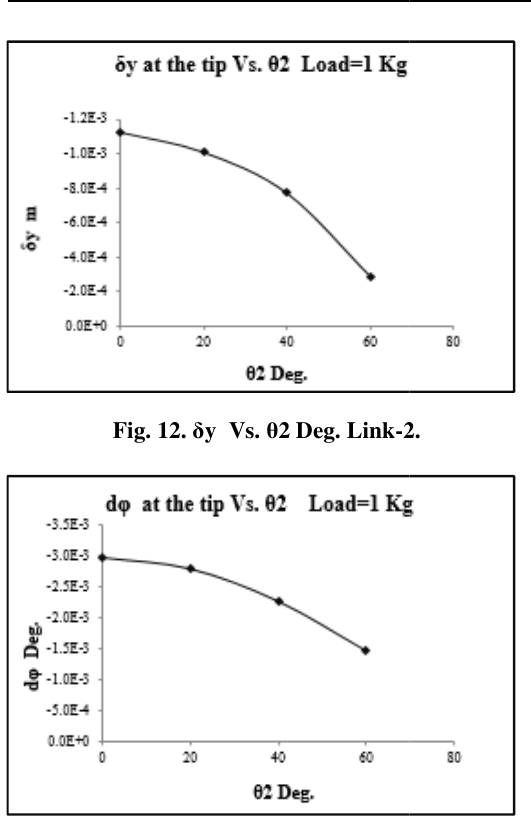
Fig. 13 d ϕ Vs. θ 2 Deg. Link-2